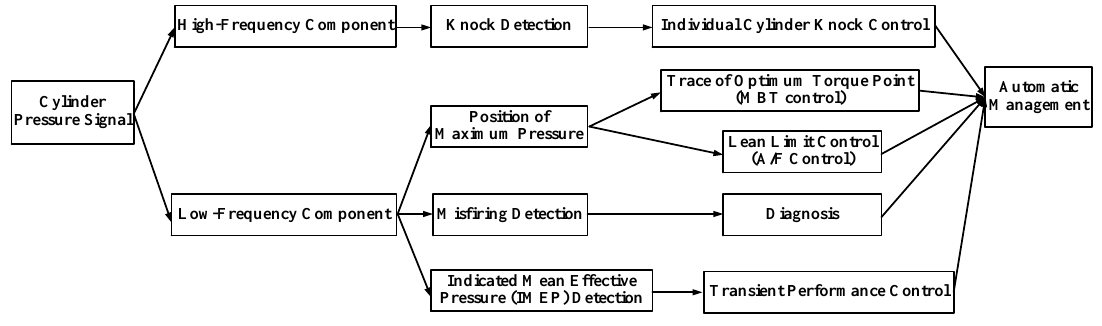
Figure 1. The typical application scenarios of cylinder pressure signals [24].